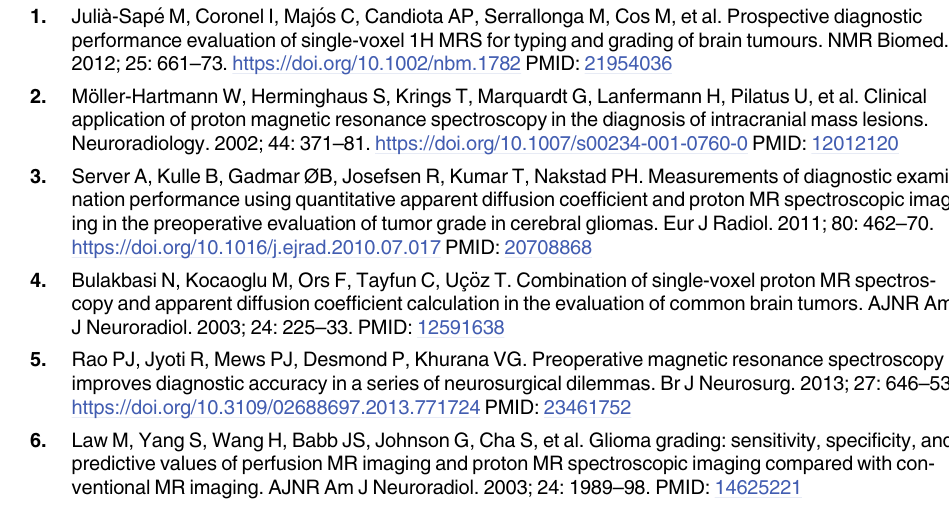
S1 Table. Principles of the MRS